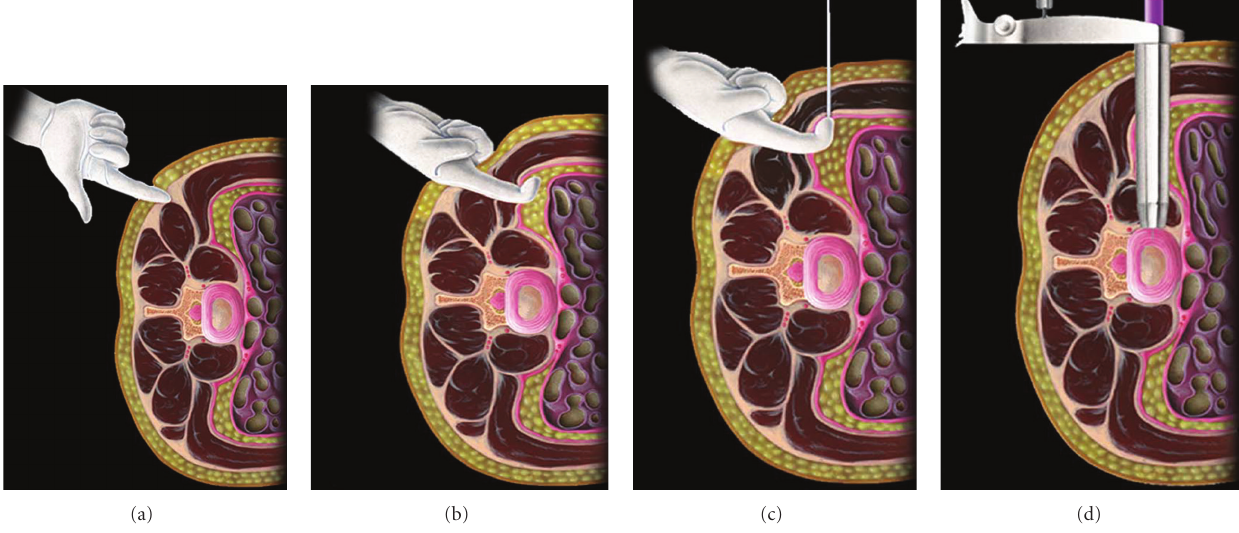
Figure 2: Two incision technique for a lateral transpsoas approach. (a) Surgeon’s Finger traversing paraspinal muscle incision site, (b) finger identifying the retroperitoneal space, (c) surgeon’s finger guiding the first dilator onto the psoas major, and (d) dilator in place traversing the psoas major directly over the intended intervertebral disc space (image reprinted with permission from Nuvasive Inc., San Diego,